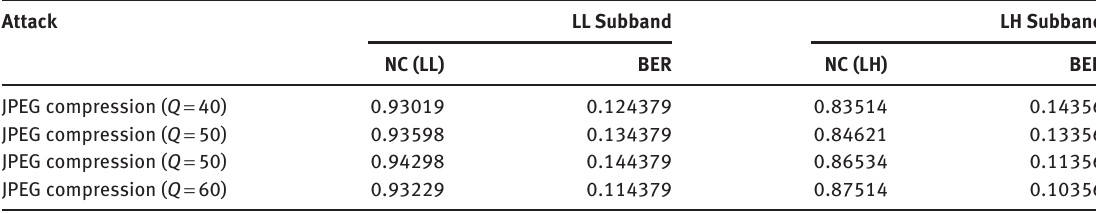
Table 7: Robustness against JPEG Compression Attacks.